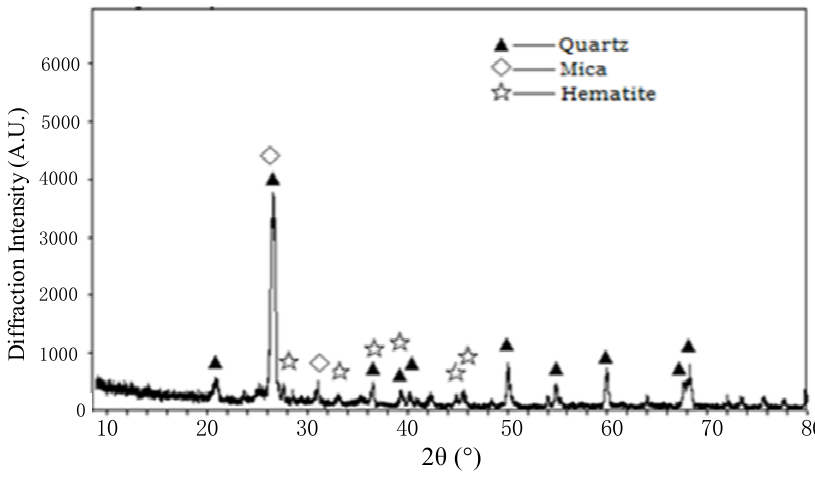
Figure 2. An X-ray diffraction analysis (XRD) of mill